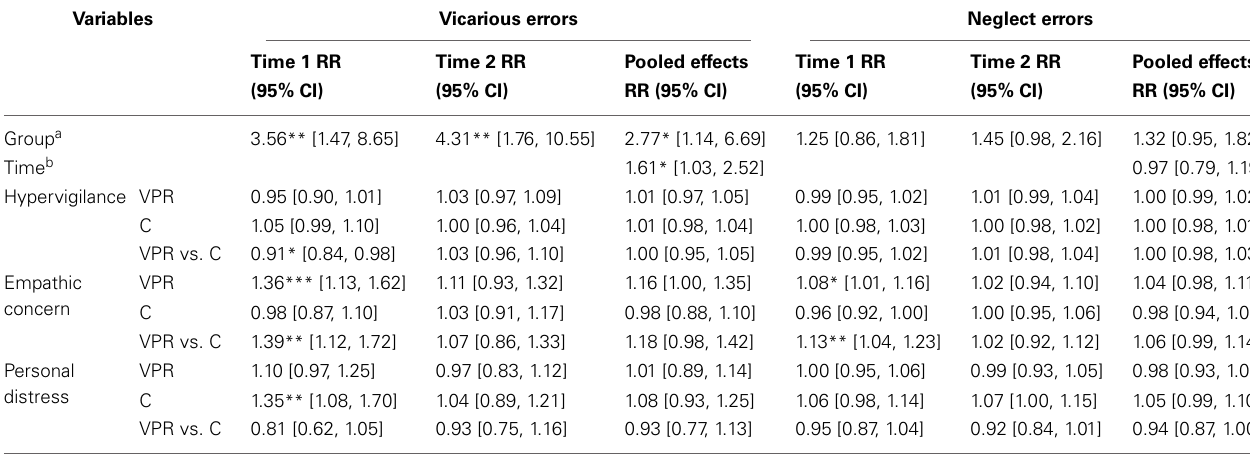
Table 4 | Rate Ratio and Confidence Intervals for neglect errors and vicarious errors (T1, T2 and pooled effects). Variables